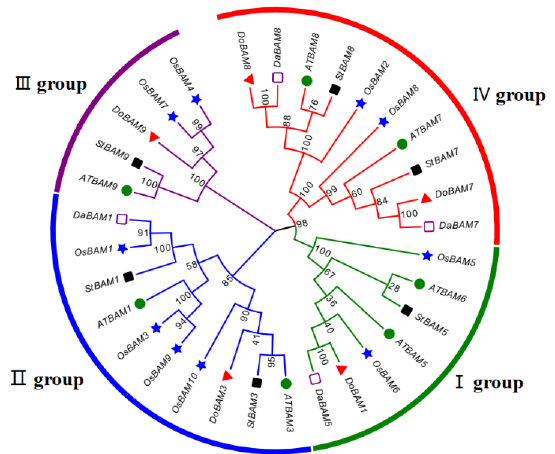
Figure 4. Phylogenetic analysis of DoBAM1 using 5 DoBAMs from yam, 7 AtBAMs from Arabidopsis , 4 DaBAMs from water yam, 6 StBAMs from potato, and 10 OsBAMs from rice. Red indicates IV group, green indicates I group, blue indicates II group, and purple indicates III group. The red data indicate DoBAM1.